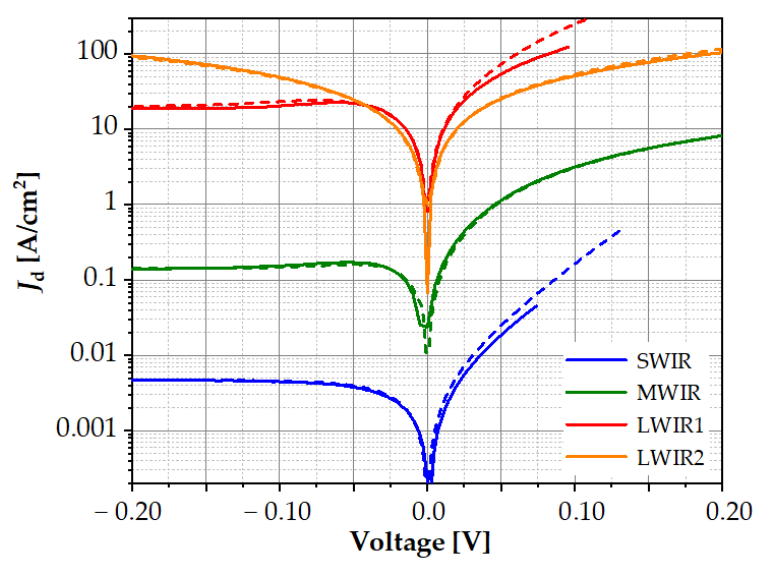
Figure 11. Current–voltage characteristics of the SWIR, MWIR, and LWIR diodes taken at 300 K. The solid and dashed lines denote experimental and theoretical data, respectively. Table 2. HgCdTe material parameters at 300 K obtained after fitting simulated and measured I–V characteristics for different spectral ranges.